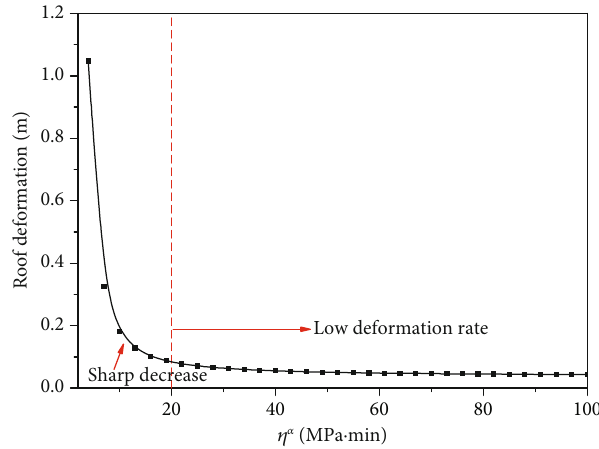
Figure 11: Relationship of maximum roof subsidence and